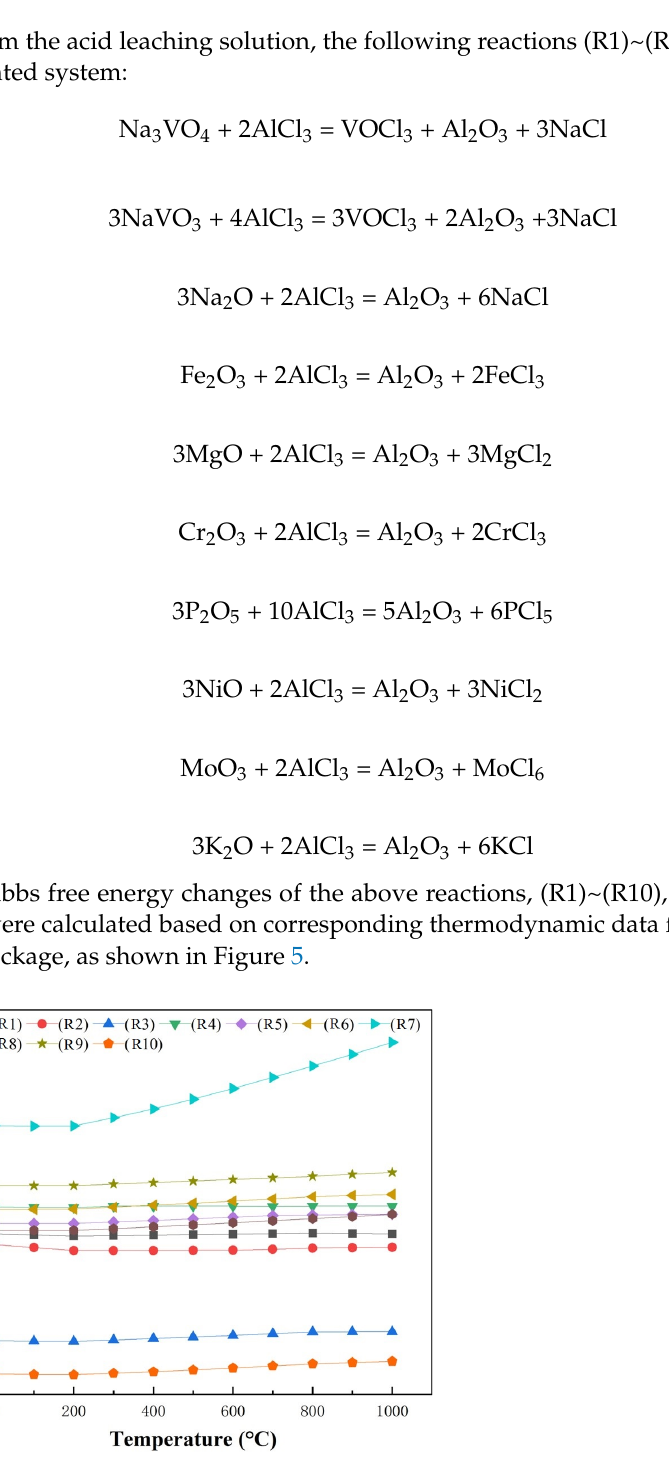
Figure 5. Gibbs free energy changes of related reactions at di ff erent temperatures.